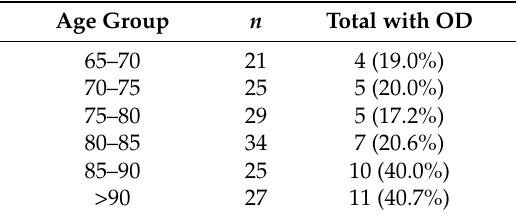
Table 3. Incidence of oropharyngeal dysphagia (OD) by age group.